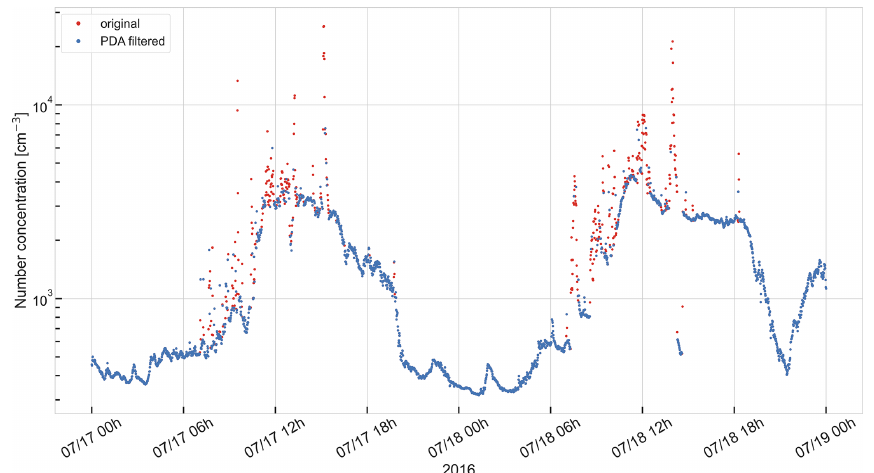
Figure A10. Time series of the particle number concentration dataset from JFJ after the application of the PDA. Original data are shown in red, overlaid with unaffected data filtered by the